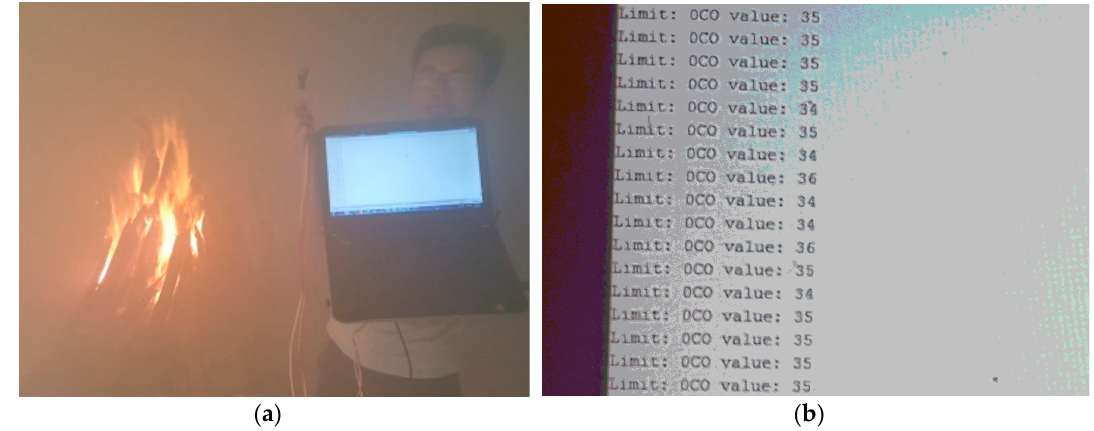
Figure 14. ( a ) Testing and measuring the CO level in the fire; ( b ) the measured CO values.